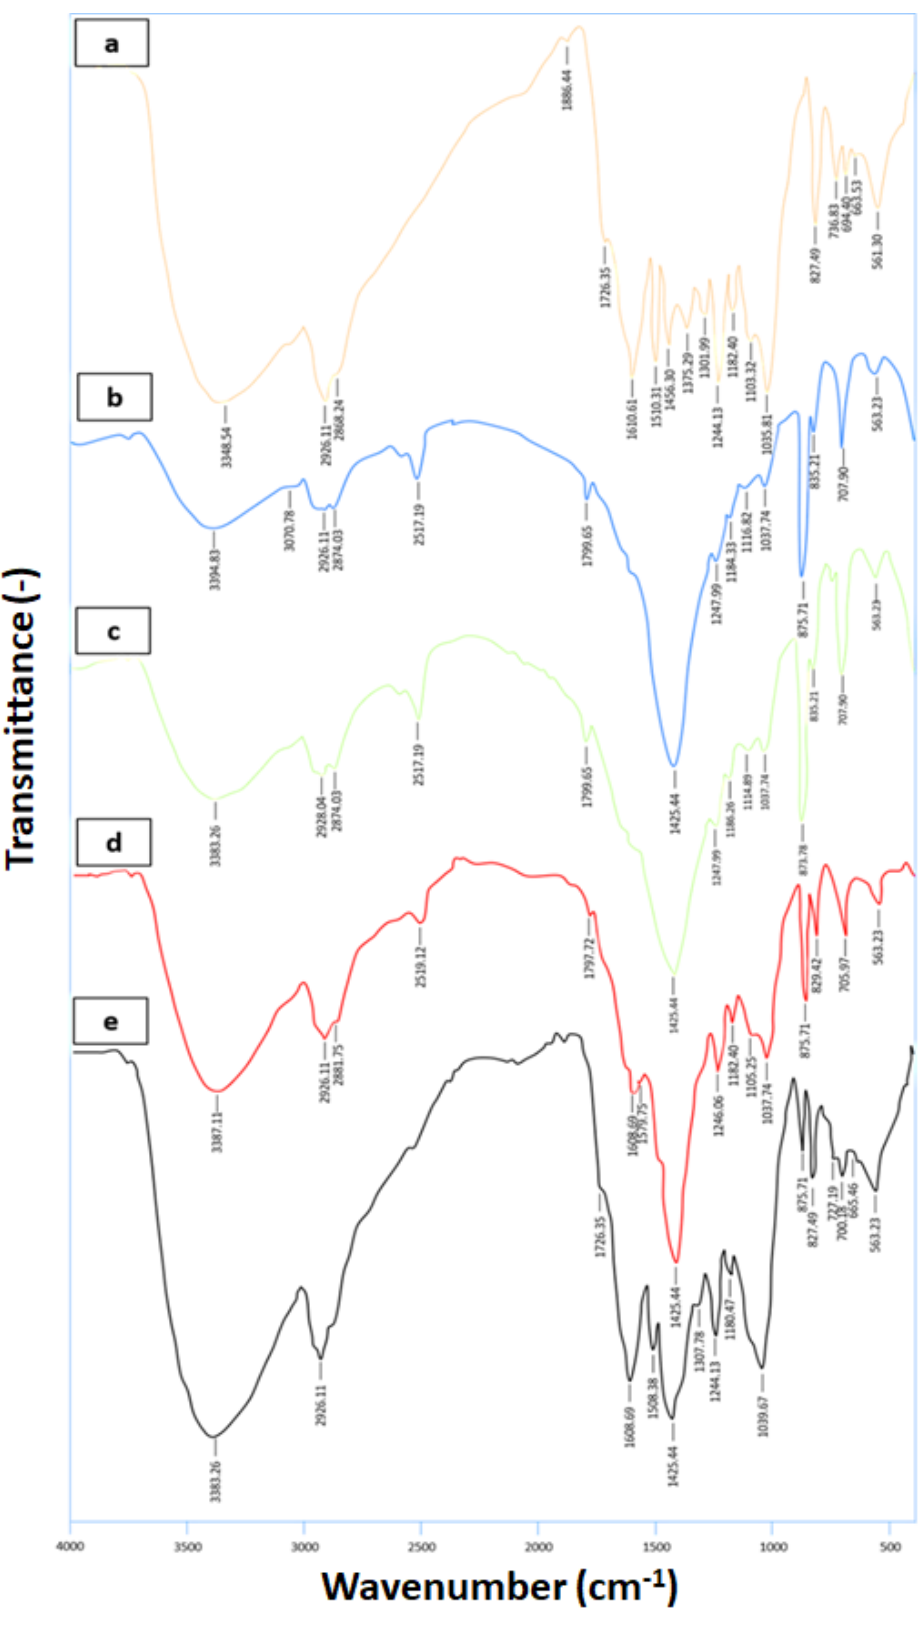
Fig. 2. FTIR spectrum of fabricated brake pad in several samples: (a) BP; (b) ES; (c) ES/BP1; (d) ES/BP2; and (e) E/BP3 The absorption band at 1800-1700 cm -1 showed the carbonyl in hemicellulose or carboxylic acids in lignin [28]. The stretching (C=O) vibration. In all four brake pad specimens absorption band around 1610 cm -1 was also related to the (BP, ES/BP1, ES/BP2, ES/BP3) except E brake pad specimens, stretching of the carbonyl group (amide). Then, the five brake the existence of this C=O group showed the ester group bond pad specimens also had absorption bands in the 1700-1500 cm